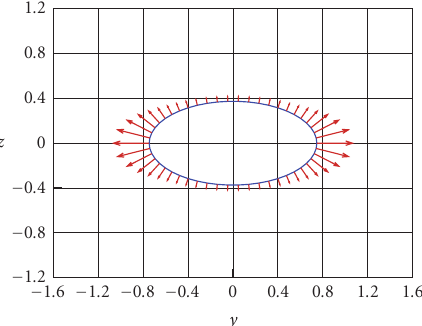
Figure 6.8. Normal stress ( T nn n y + T nn n z ) / 150dyn/cm 2 for an ellipse y 2 /b 2 + z 2 /c 2 = 1 − 2 . 0 2 /a 2 at x = 2 . 0 cm in the ( y , z )-plane. Perpendicular view of the cross section (g) in Figure 6.1. Strong tension at the right and left poles causes the ellipsoid to get flatter.